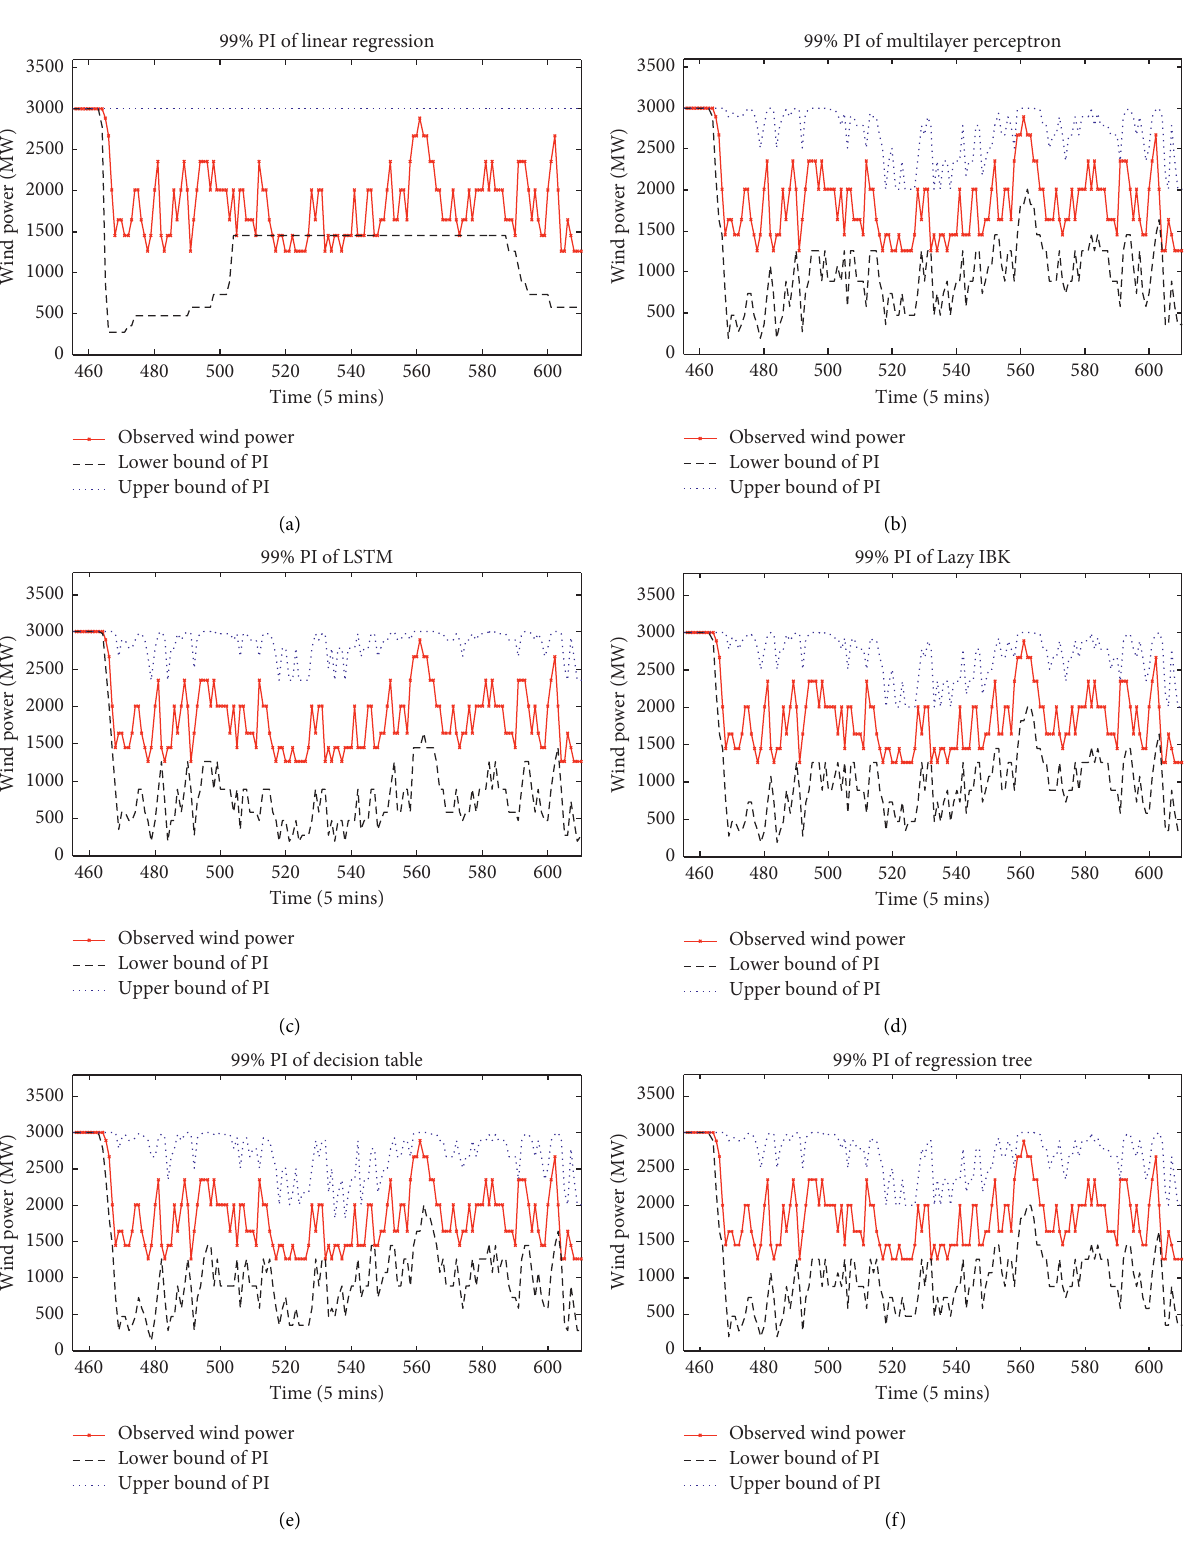
Figure 7: 99% level prediction intervals forecasted by six machine learning regression